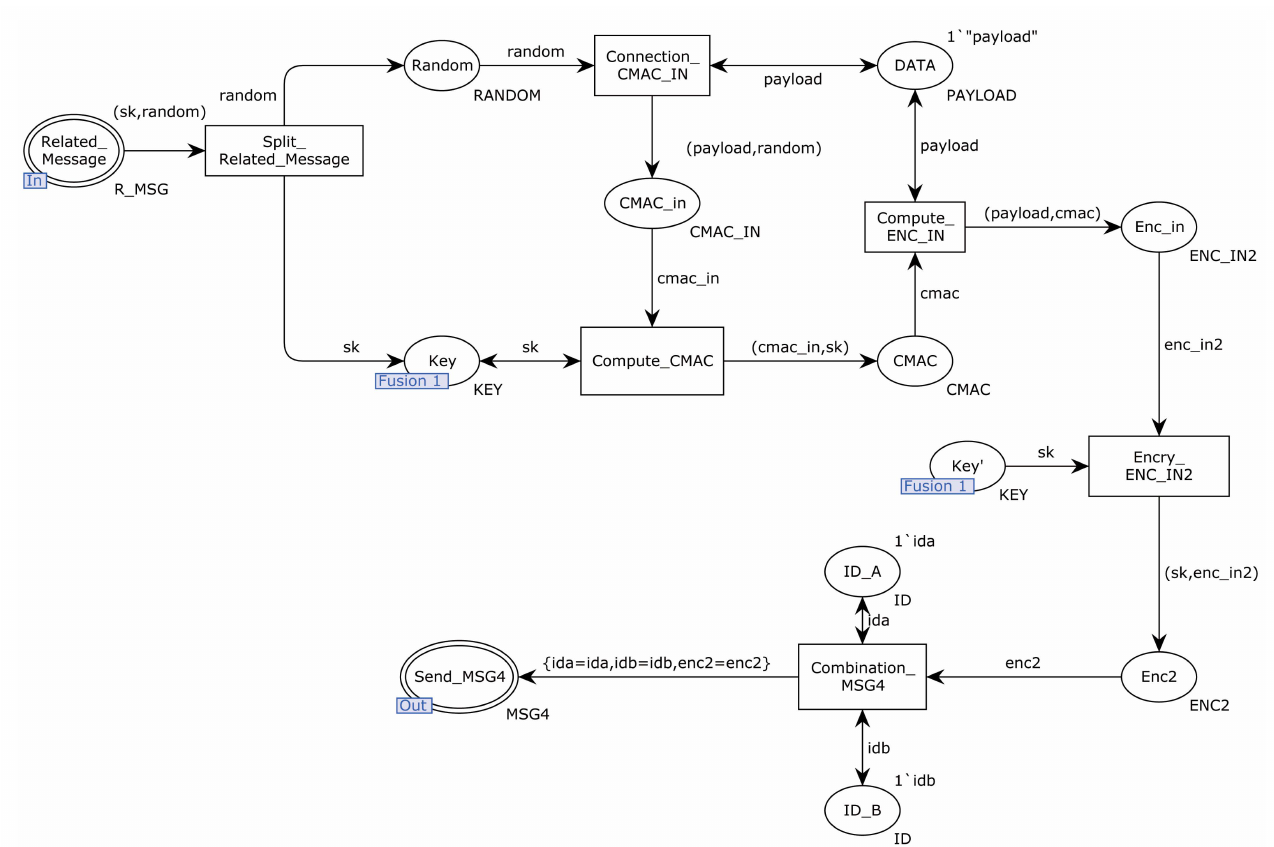
Figure 5. Substitution transition authentication internal